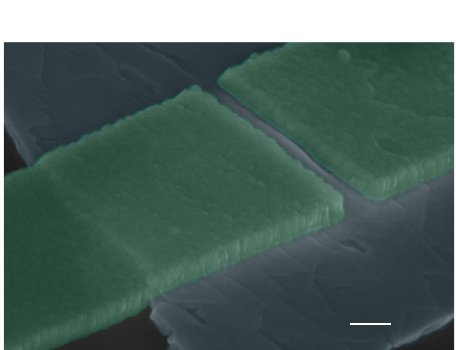
Fig. 3 Colored SEM image of a typical junction after the second cool